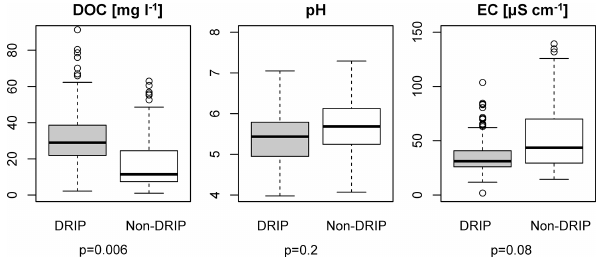
Figure 3. Groundwater chemistry of DRIPs vs. non-DRIPs. DRIP boxplots are presented in gray, and non-DRIP boxplots are shown in white. Each panel represents one response variable. Whiskers repre- sent the 25th and 75th percentile. The p values were obtained using an F test, and p values < 0.05 were considered significant.